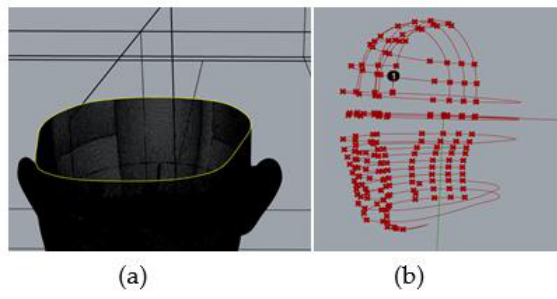
Figure 8. ( a ) Curve extraction; ( b ) curve fitting.